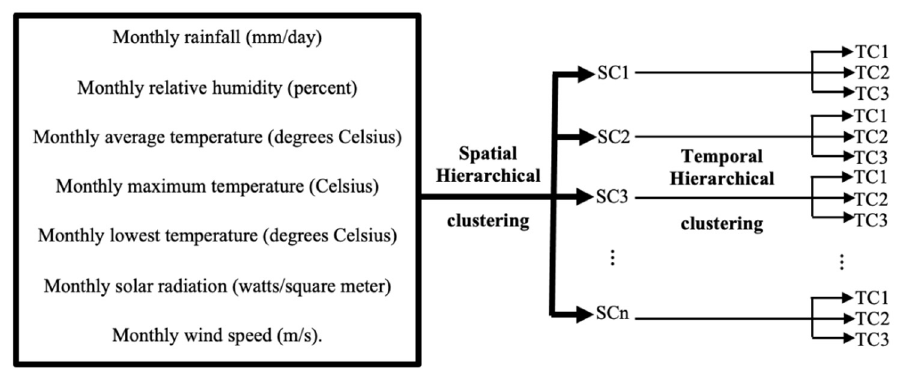
Figure 1. The multivariable panel data clustering framework.